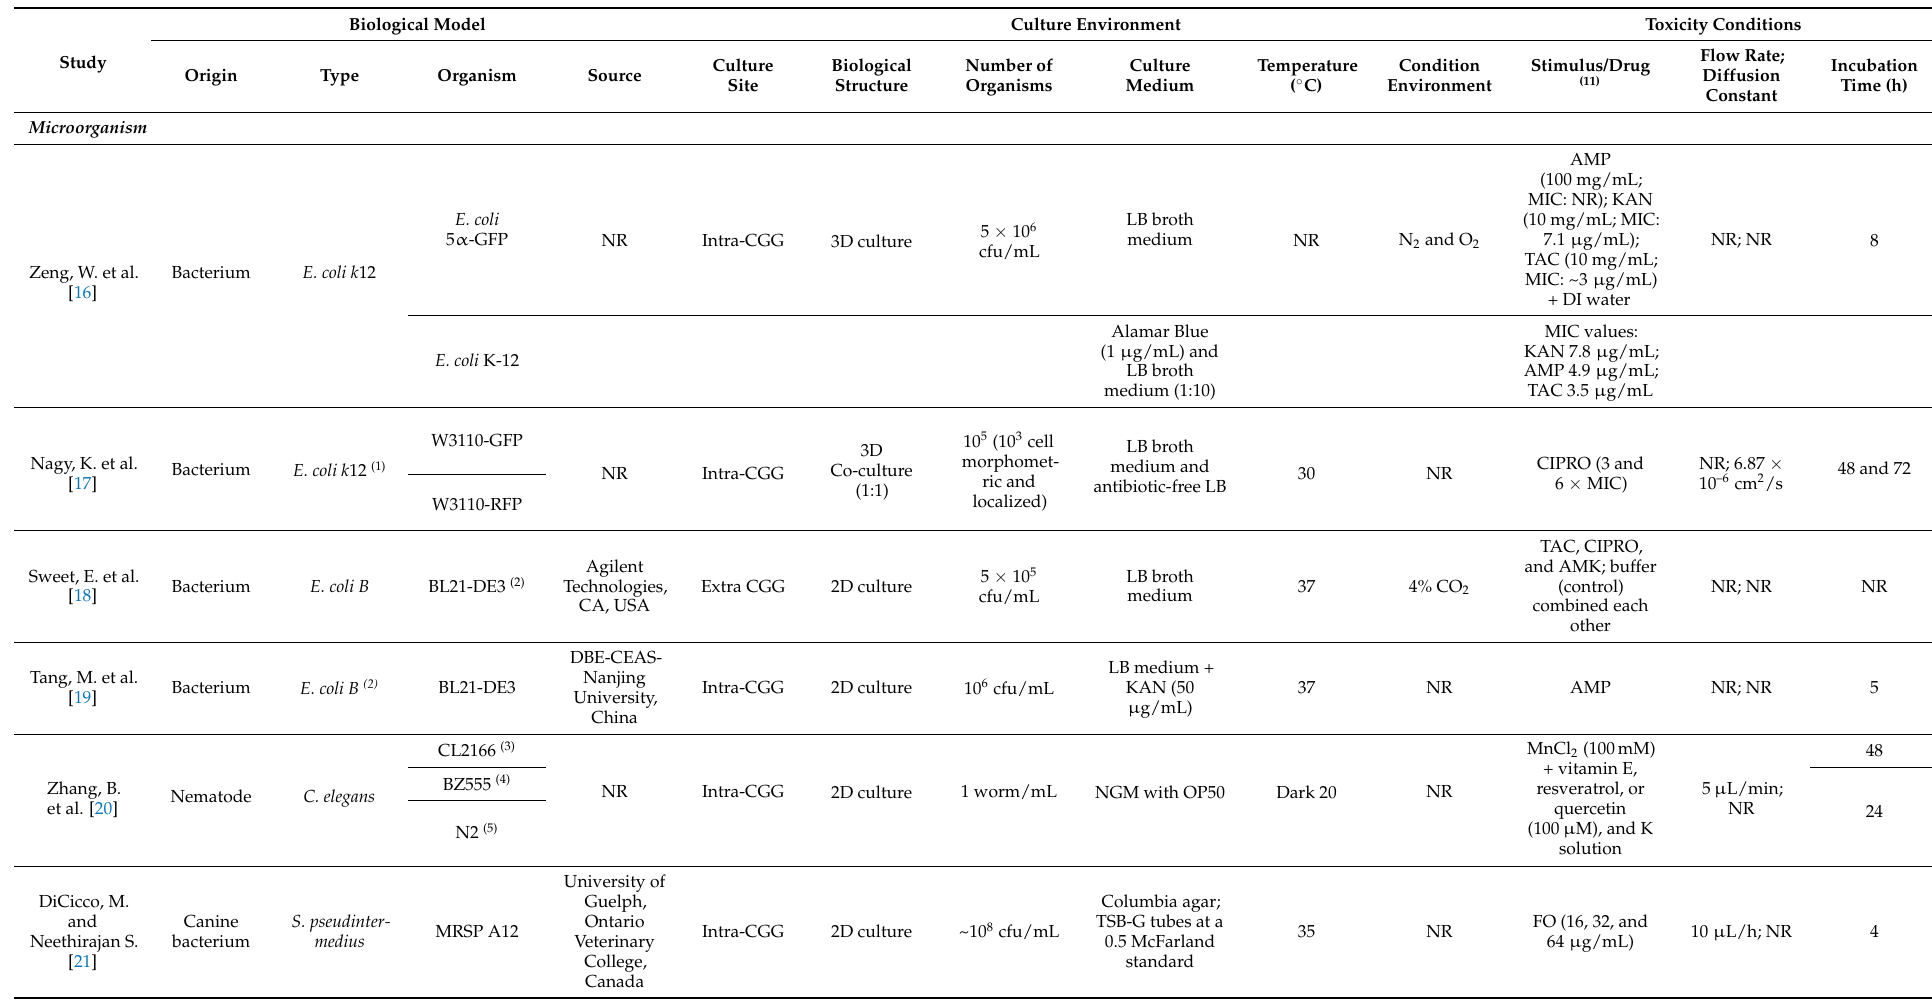
Table 3. Biological model used for toxicity evaluation in CGG microfluidic